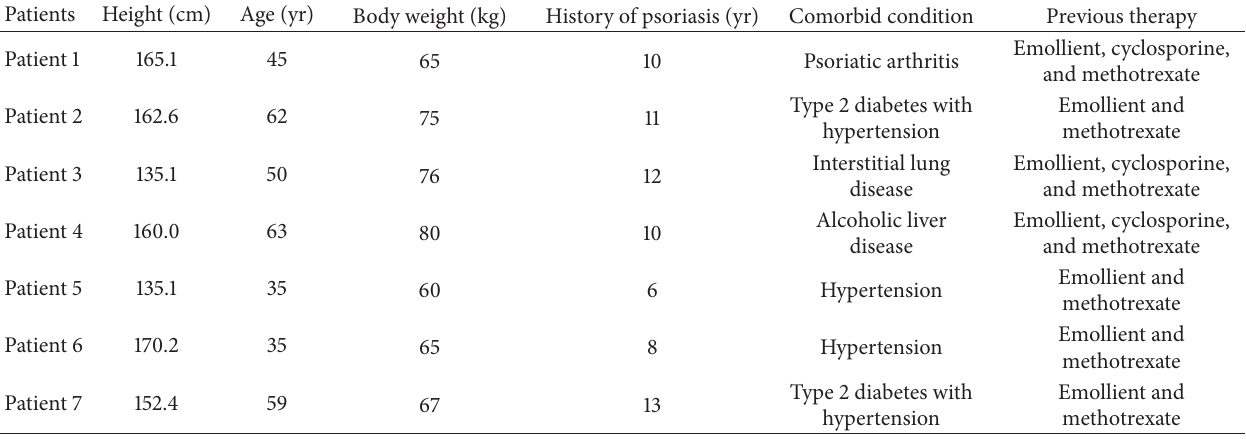
Table 1: Demographic and comorbidity details of patients.